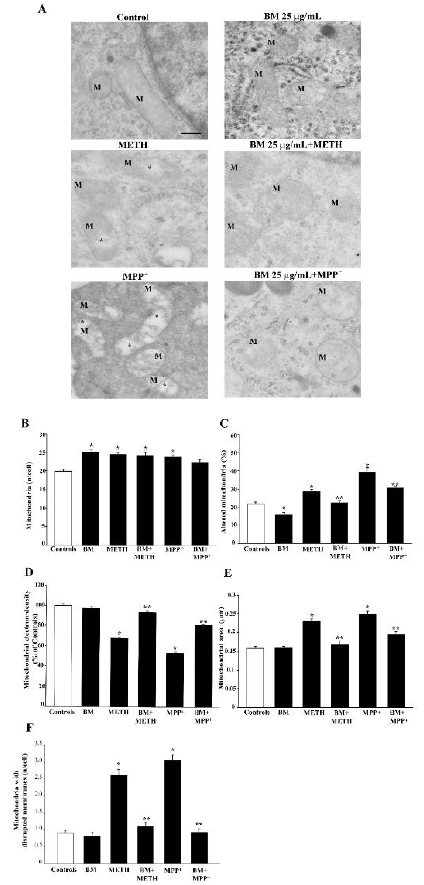
Figure 15. Effects of combined treatment with BM (25 μ g/mL) and METH or MPP + on mitochondrial ultrastructural morphometry. ( A ) Representative micrographs of mitochondria show that METH induces mitochondrial alteration, consisting of matrix dilution (*) and fragmented cristae. These mitochondrial alterations are even more severe after MPP + , which induces a marked loss of matrix electron density (*). Pre-treatment with BM (25 μ g/mL) counteracts the mitochondrial alterations induced by both neurotoxins. Graphs report the effects of combined BM (25 μ g/mL) and METH or MPP + treatment on the number of total mitochondria per cell ( B ), the percentage of altered mito- chondria per cell ( C ), the electron density of the mitochondrial matrix ( D ), the mitochondrial area ( E ), and the number of mitochondria with disrupted membranes ( F ). Values are given as the mean ± S.E.M. ( B , E , F ) or mean percentage ± S.E.M. ( C , D ) of measures from three independent experi- ments. * p < 0.05 compared with controls; ** p < 0.05 compared with METH or MPP + . M = mitochon- dria. Scale bar = 230 nm.